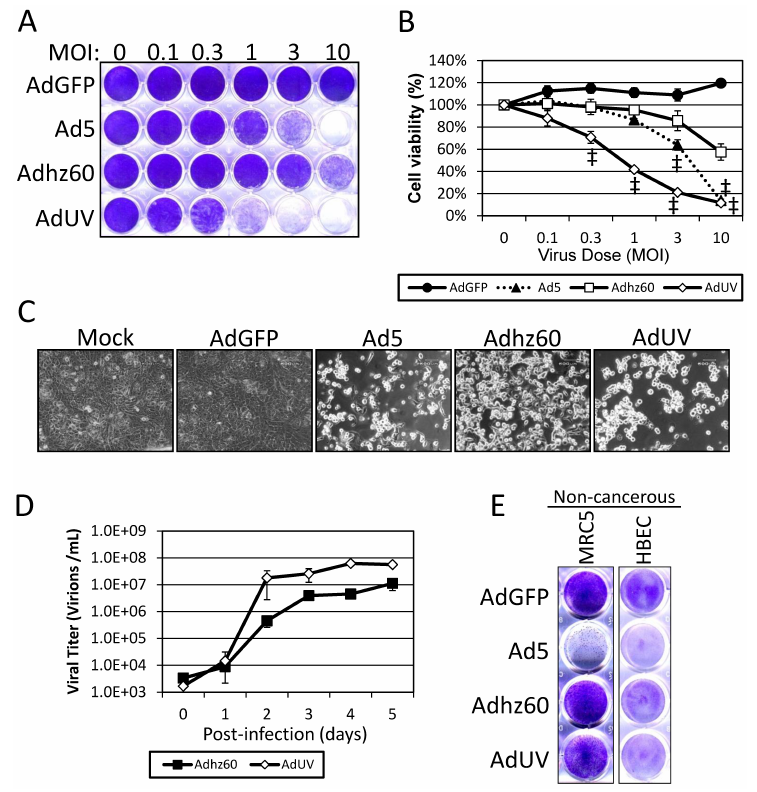
Figure 2. AdUV is released from and lyses A549 cells more efficiently than Adhz60. ( A ) A549 cells stained with crystal violet after five days’ treatment with the indicated Ads and MOIs; ( B ) Quantification of A549 cells stained with crystal violet expressed at the percent (%) viability; ( C ) Cytopathic effects (CPE) in A549 cells treated at an MOI of 1 for the indicated Ads were photographed at 200× total magnification five days post-­‐‑infection; ( D ) A549 cells were infected with at an MOI of one with Adhz60 and AdUV and media samples were collected daily until day 5. Ad titer was determined via the TCID50 method using HEK293 cells. Day zero represents samples collected at 6 h post-­‐‑infection; ( E ) Crystal violet staining of non-­‐‑cancerous lung fibroblasts (MRC5) and epithelial (HBEC) cell lines treated at an MOI of 10 for three days. Quantified data are shown ± the standard deviation (SD) of three independent replicates. Statistical significance was assessed via two-­‐‑way ANOVA relative to Adhz60 treated cells with multiple comparisons corrected for by Bonferroni’s method. ‡ indicates p -­‐‑value > 0.001.